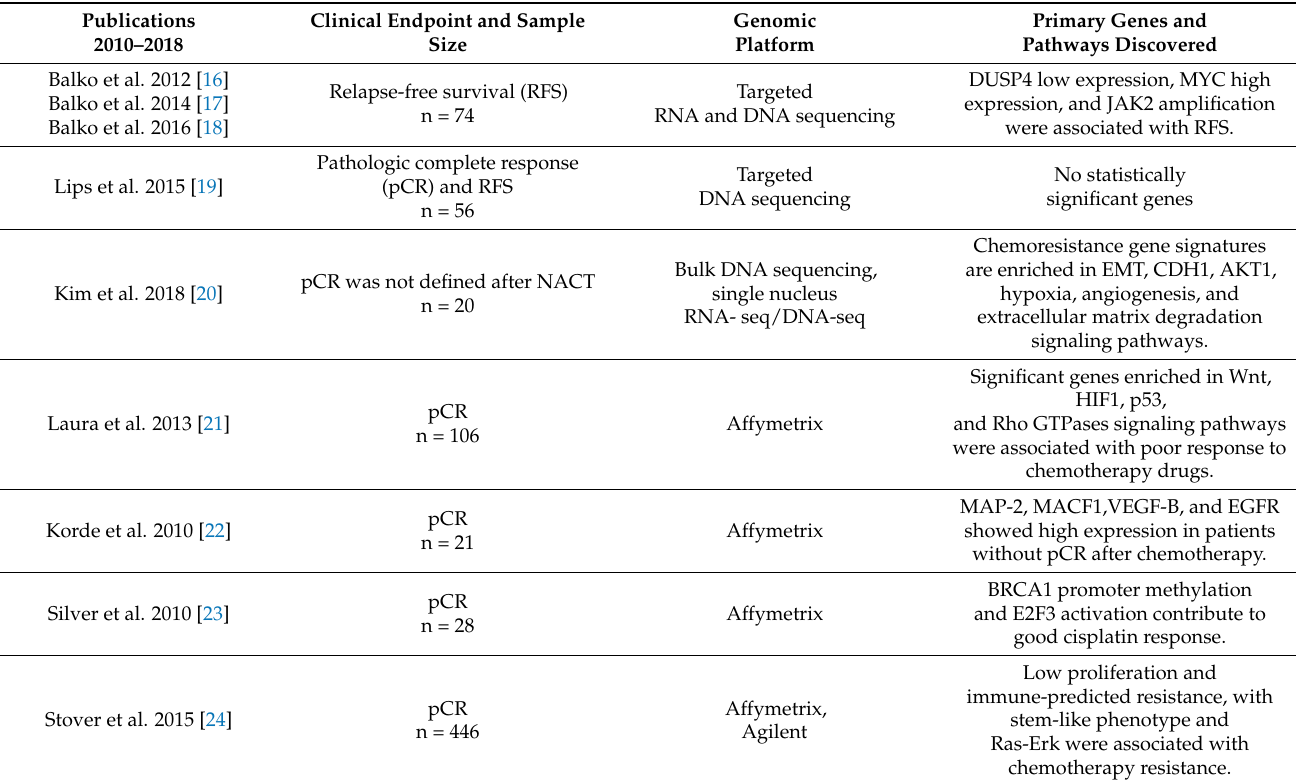
Table 1. Clinical genomic studies of chemotherapy resistance in breast